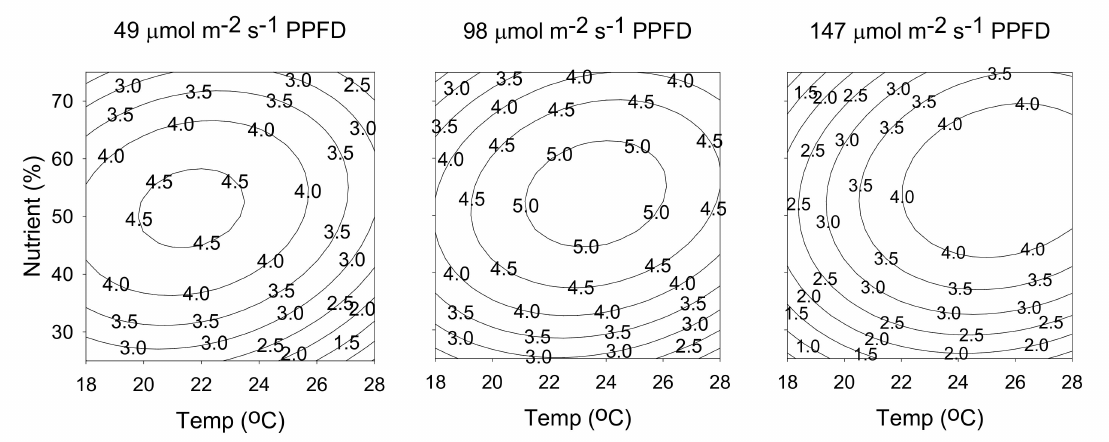
Figure 9. Contour plots of production yield of hyperforin. The numbers inside the contour plots indicate production yield (mg / plant) at given cultivated